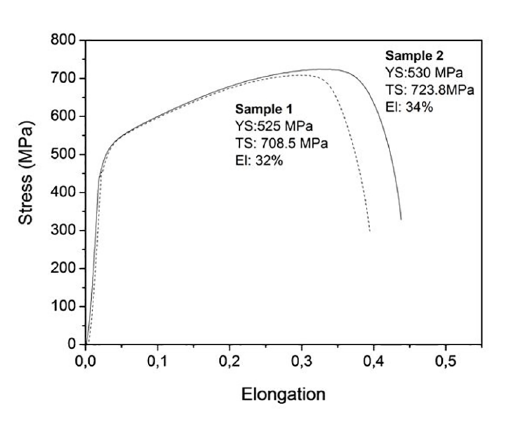
Figure 4. Stress-strain curves of Ti-12Mo-8Nb alloy at room